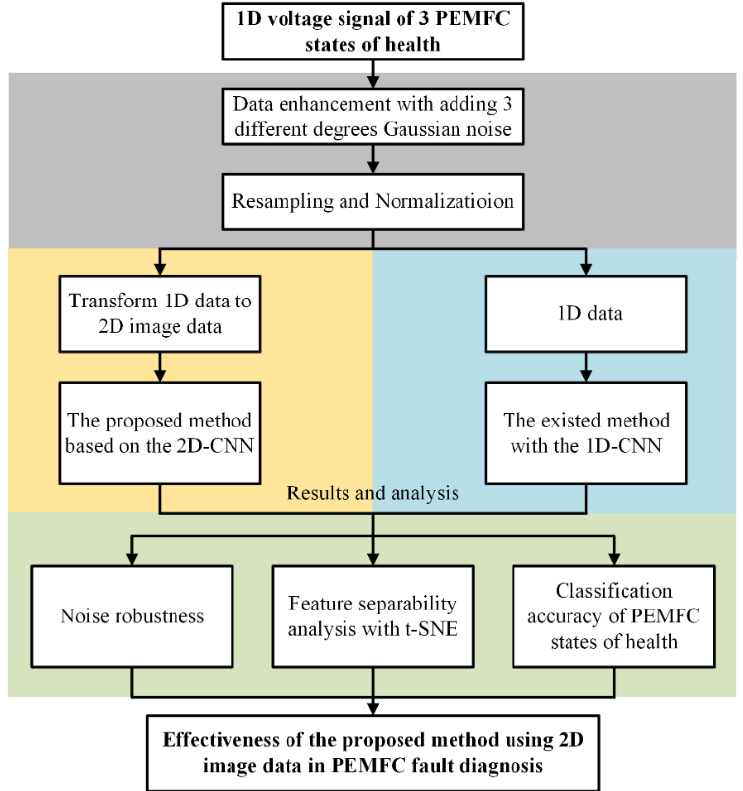
Figure 1. Flowchart of using the proposed method based on the two-dimensional convolutional neural network (2D-CNN).